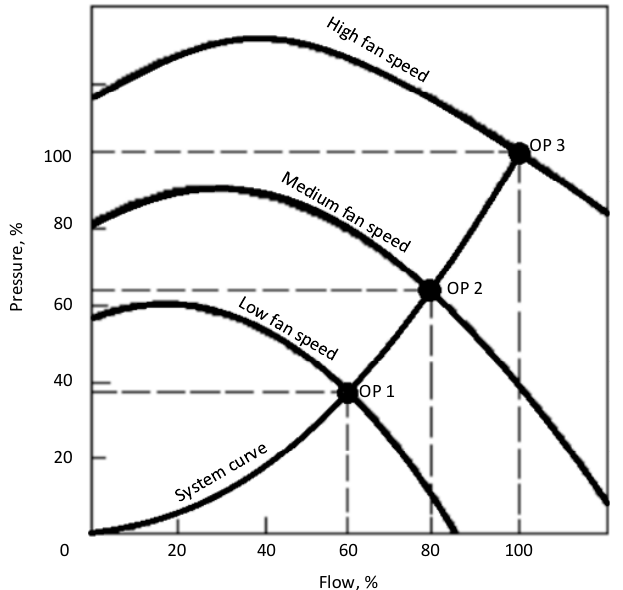
Figure 2. Variable speed fan providing the operating point at the required flowrate (based on [53–55]). The fan characteristic is represented by a fan curve, which shows the relationship between static pressure and the air flow rate of the fan. The resistance to air flow through the installation is shown by a system curve. Point OP (1–3), located at the intersection of both curves, constitutes the operating point at given fan operating parameters. It determines the actual flow and pressure developed by the fan in a given